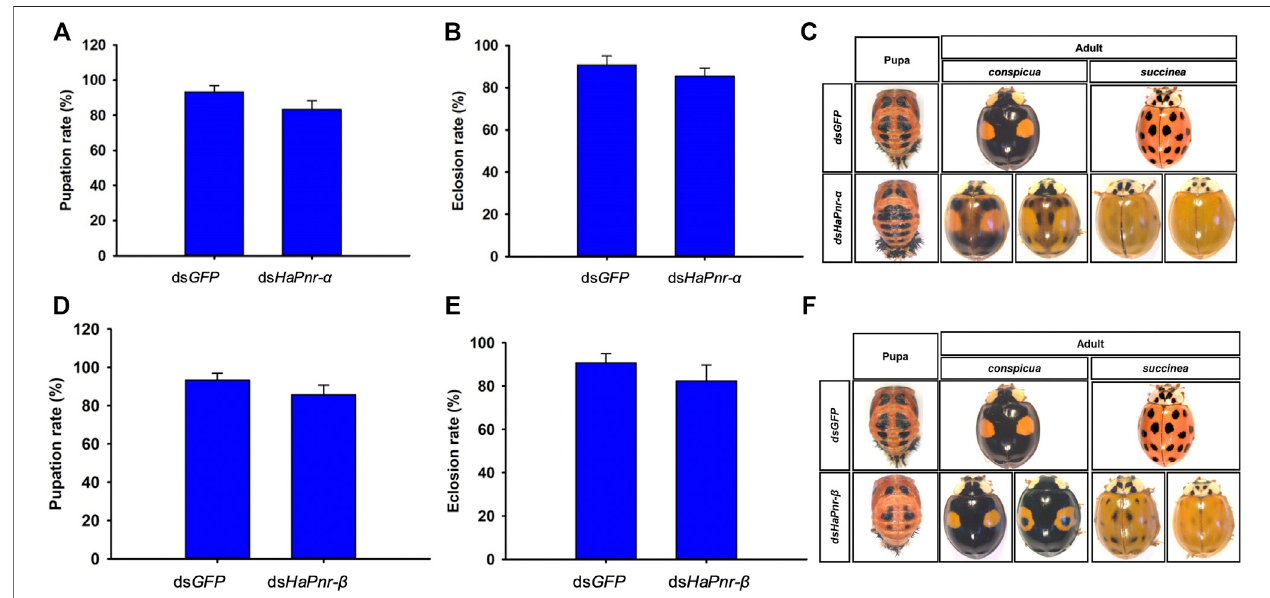
FIGURE 7 | The pupation rate in ds HaPnr- α (A) and ds HaPnr- β (D) injected groups compared with ds GFP -treated larvae, respectively. The eclosion rate in ds HaPnr- α (B) and ds HaPnr- β (E) injected group compared with ds GFP -treated larvae, respectively. The pupae and adult ’ s phenotype after the fourth instar larvae injectedwithds HaPnr- α (C) andds HaPnr- β (F) .Theresultsarepresentedasthemeanandstandarderrorsofthreereplicates;eachwasperformedwithanRNAsample prepared from three insects. Asterisks above the standard error bars indicate signi fi cantly different (Duncan tests, p <